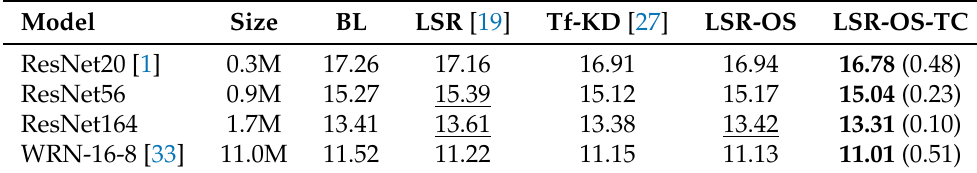
Table 3. Test set error rate comparison on the CINIC10